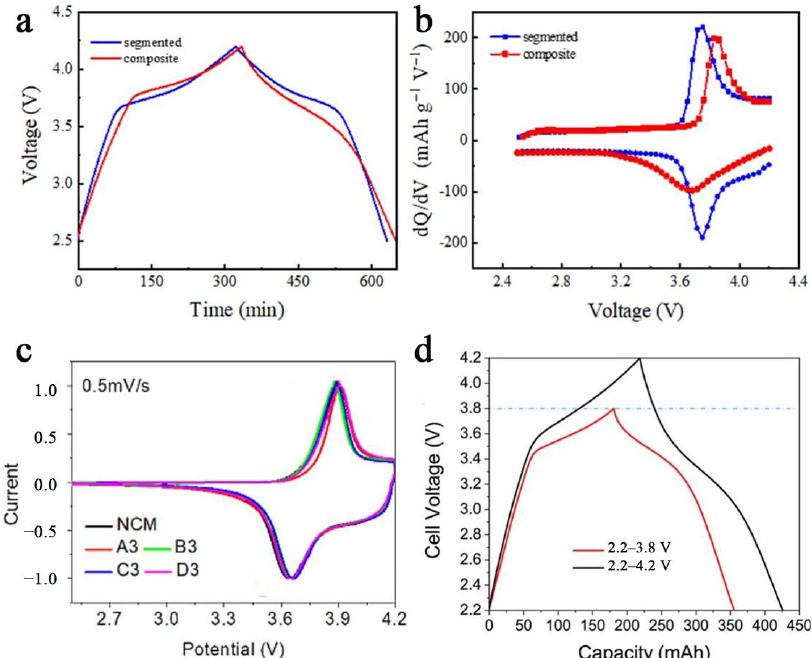
Figure 11. Polarization phenomenon of LIBCs: ( a ) Charge/discharge profiles, and ( b ) differential capacity versus potential curves of the half-cells with different cathode structures [61]; ( c ) CV curves [62]; ( d ) Charge/discharge profiles under different voltage range [88]. Table 1. Polarization phenomenon of selected NCM-based LIBCs.